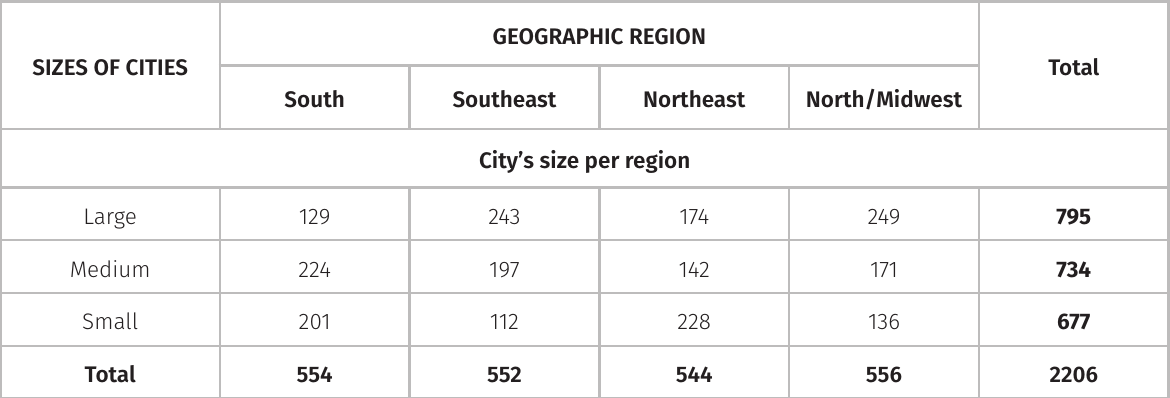
Table I. Distribution of interviews carried out in the three sizes of cities, distributed across four geographic